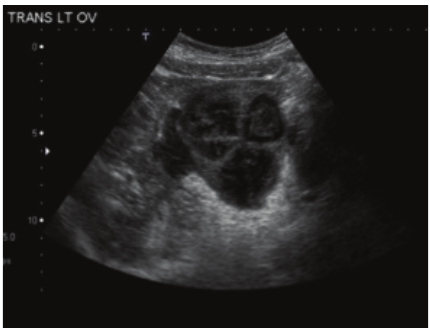
Figure 2: Ultrasound image showing large, complex cystic mass in the left adnexa measuring 5.9 × 8.4 × 5.5 cm in dimensions.